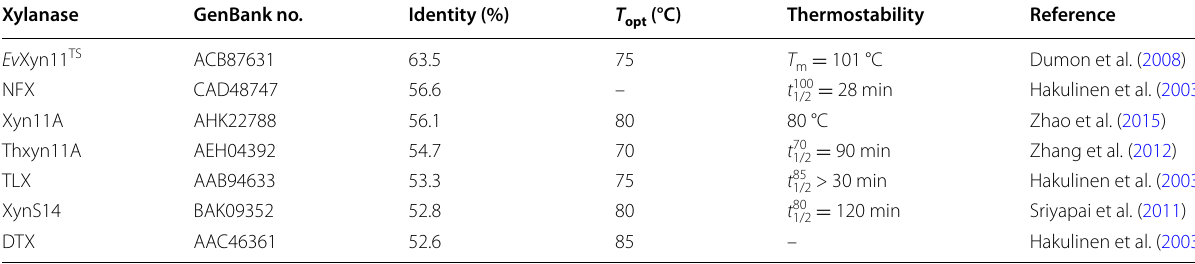
Table 1 The temperature characteristics of seven representative thermophilic GHF11 xylanases Xylanase GenBank no. Identity (%) T opt